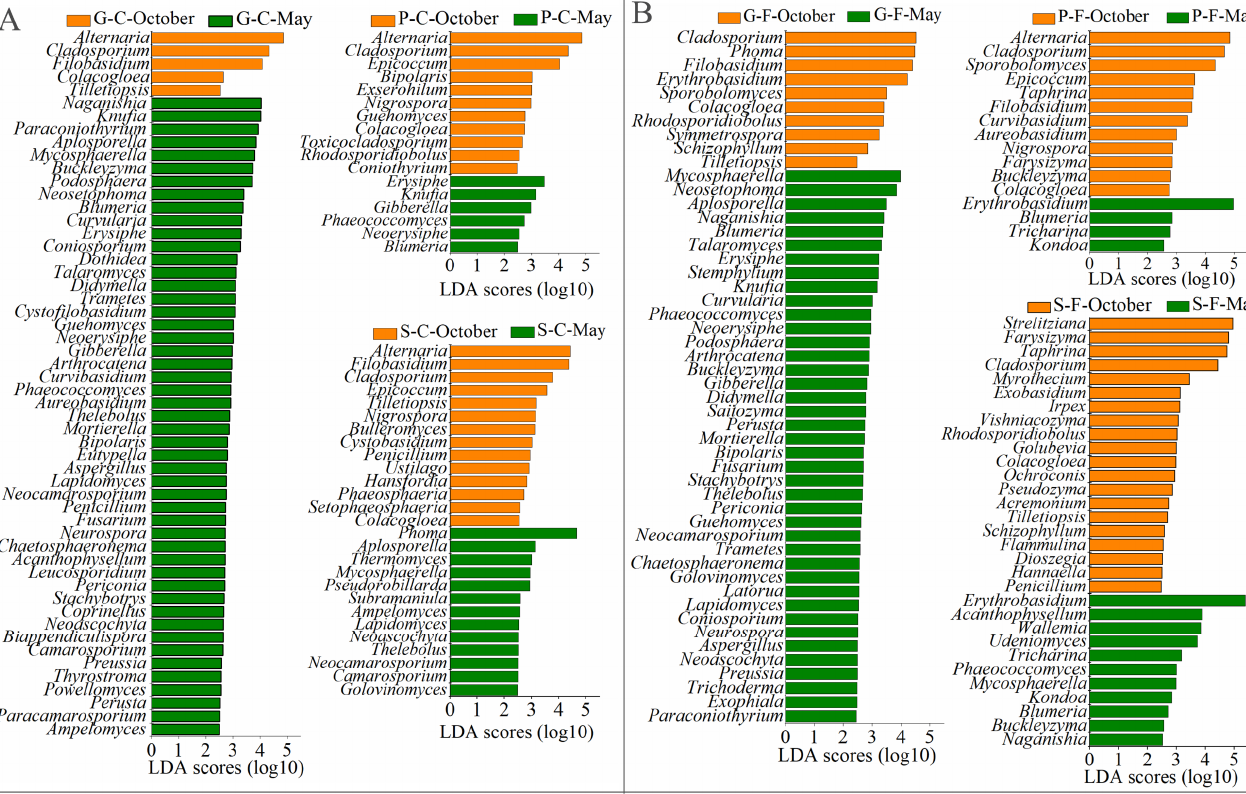
Figure 3. Taxonomic differences at genus level among phyllospheric fungi in October and May of three types of trees in campus ( A ) and forest ( B ) by a linear discriminant analysis (LDA). G-C-October, G. biloba from campus obtained in October; G-C-May, G. biloba from campus obtained in May; P-C-October, P. bungeana from campus obtained in October; P-C-May, P. bungeana from campus obtained in May; S-C-October, S. chinensis from campus obtained in October; S-C-May, S. chinensis from campus obtained in May; G-F-October, G. biloba from forest obtained in October; G-F-May, G. biloba from forest obtained in May; P-F-October, P. bungeana from forest obtained in October; P-F-May, P. bungeana from forest obtained in May; S-F-October, S. chinensis from forest obtained in October; S-F-May, S. chinensis from forest obtained in